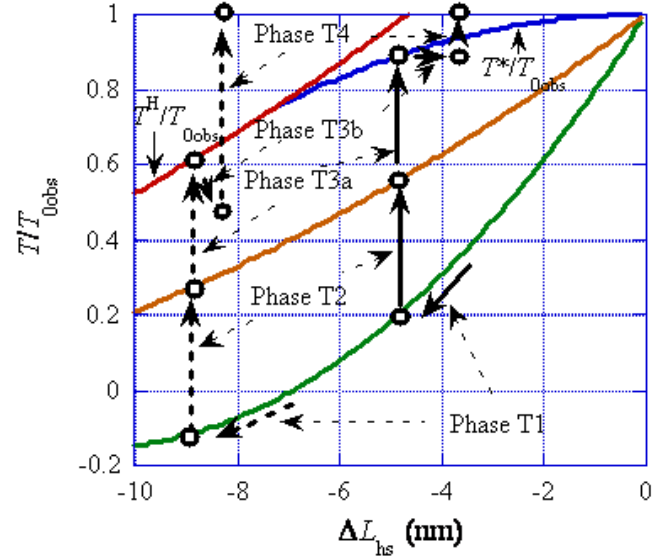
Figure 13. Phases in the isometric tension transient on the T / T thick black solid and dashed arrows, respectively, indicate Phases in the cases of < y and  y > y . Actually the thick solid and dashed arrows are on the same  y cT1 cdev cT1 cdev vertical lines, respectively, except for the case of Phase